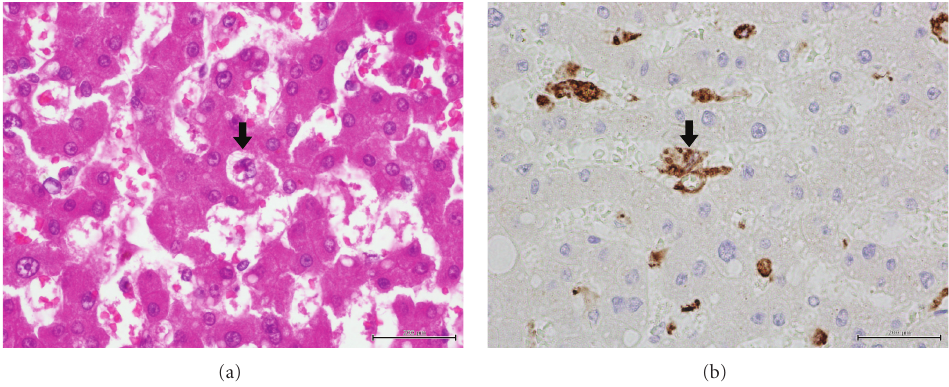
Figure 3: Liver biopsy showed hemophagocytosis (a) by the activated macrophage as stained by CD68